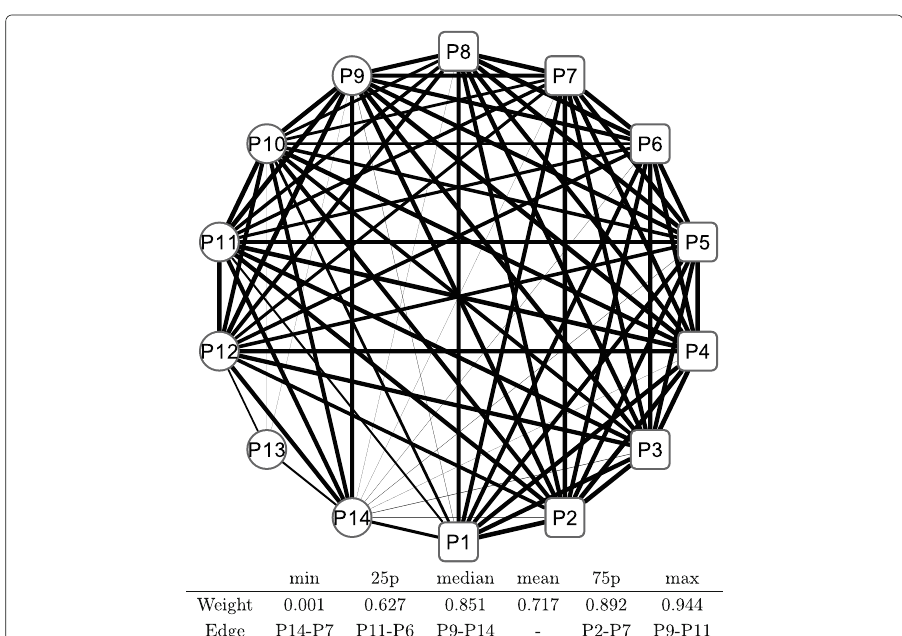
Fig. 11 Correlation network of sub-portfolios: sub-period T3. Note: The network is created based on the network adjacency matrix of the sub-period category T3. For further details, see the note of Fig.